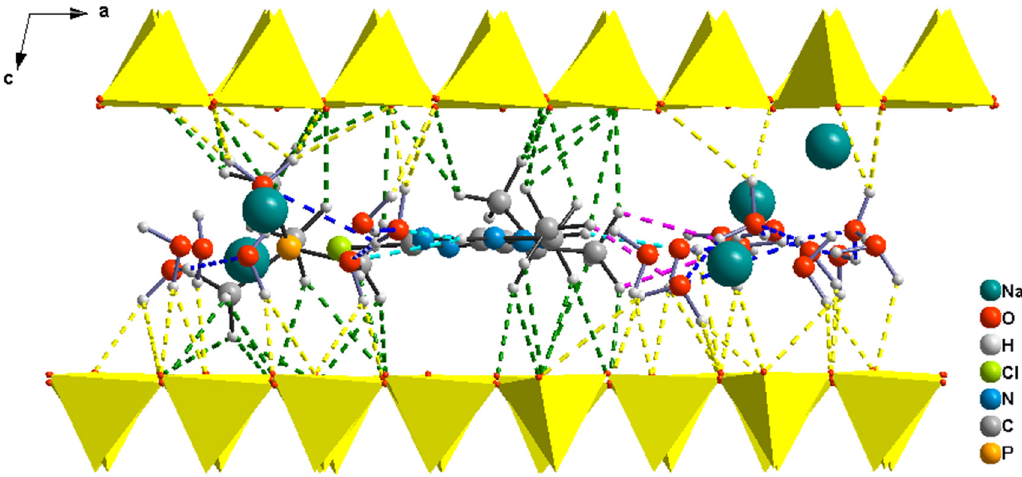
Figure 2. The hydrogen bonds in the A-TMP-Mt model as an example: green (C–H···O b ), magenta (C–H···O w ), yellow (O w –H···O b ), blue (O w –H···O w ) and cyan (N–H···O w ). Only the tetrahedral sheets are illustrated for better viewing of the hydrogen bonds.